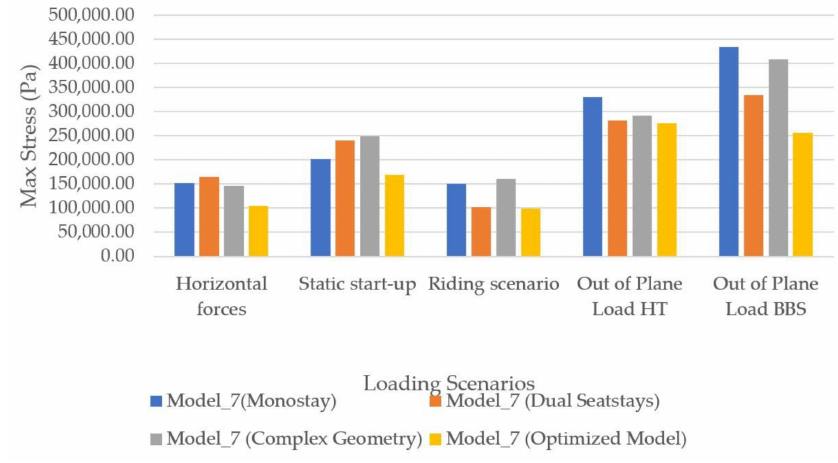
Figure 20. Maximum stress per model in horizontal forces, static start-up, riding, out-of-plane load in the headtube, and out-of-plane load in the bottom bracket shell scenarios.